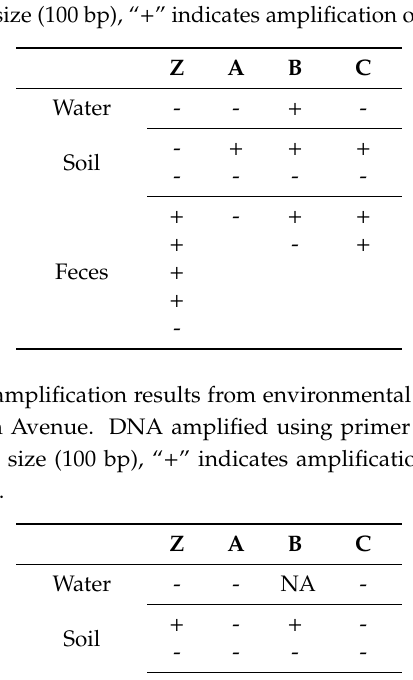
Figure 4. C. cayetanensis DNA amplification from environmental and wildlife fecal samples collected from St. Paul Woods (SPW). The transect the samples were collected from is denoted as A–C and Z followed by the sample number and type (F = feces, S = soil, and W = water). The DNA was amplified using two rounds of PCR. The 100 bp standard (located in lane 1, far left, in each image) was used to assess the amplicon size. The Cyclospora (CYC) DNA (located in lane 2 of all gels) represents the correct positive band position at 100 bp. Positive samples were identified by a positive band at 100 bp. Table 3. Summary of DNA amplification results from environmental samples collected along four transects (A–C, Z) in Caldwell Woods. DNA amplified using primer CYCLO18S, “-“ indicates no